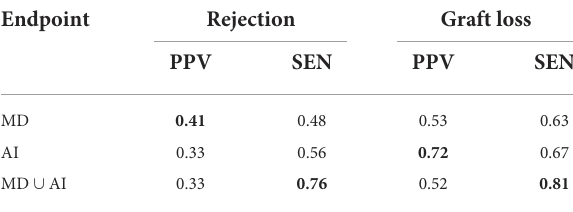
TABLE 6 Positive predictive value (PPV) and sensitivity (SEN) of MD and